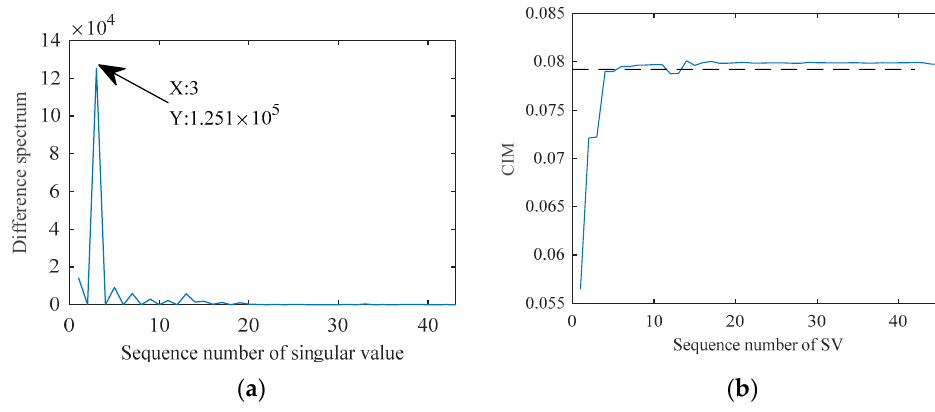
Figure 10. The difference spectrum and CIM. ( a ) Difference spectrum. ( b ) CIM value.